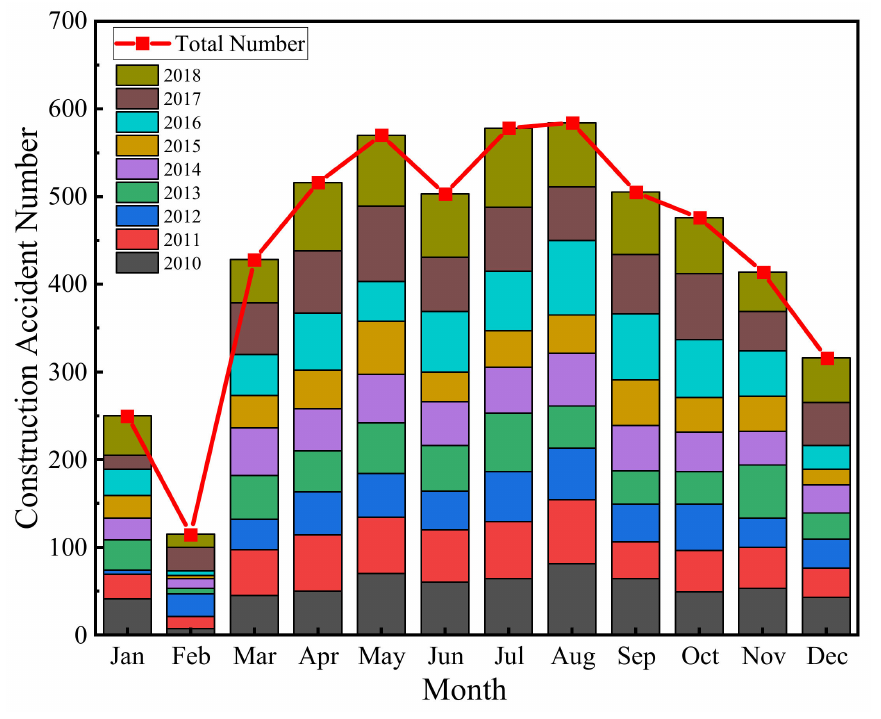
Figure 5. Number of construction accidents per